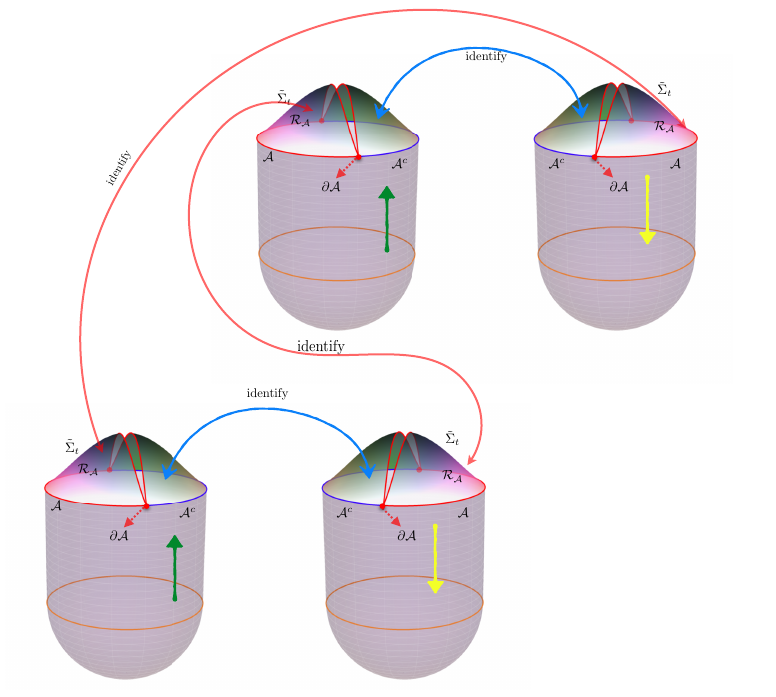
(cid:0) ( t ) (cid:1) . ρ 2 A